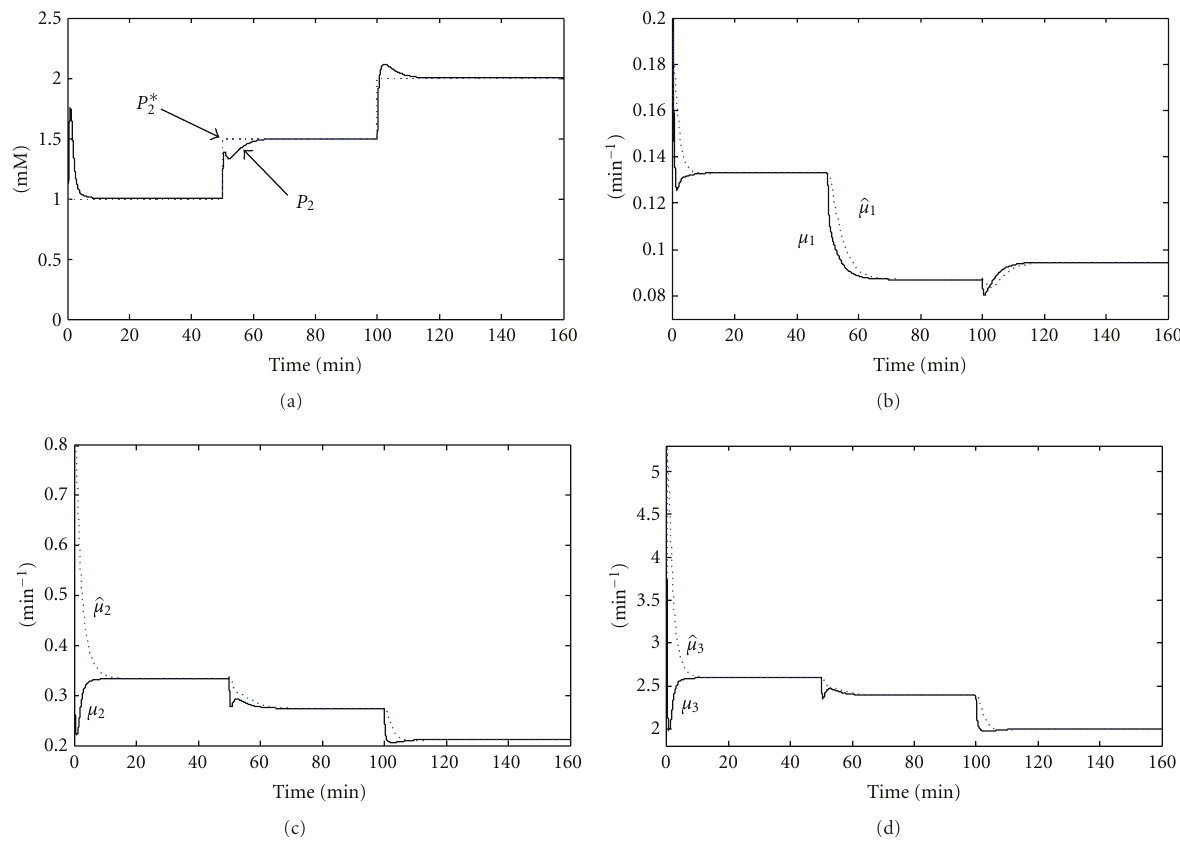
Figure 5: Simulation results—adaptive control law (free-noise measurements). Panel (a) shows the time evolution of the output y = P 2 (ampicillinconcentration) versus the reference profile y ∗ = P ∗ 2 , in the adaptive case. Panels (b), (c), and (d) present the profiles of specific reaction rates μ 1 , μ 2 , and μ 3 together with their estimates (cid:18) μ 1 , (cid:18) μ 2 , and (cid:18) μ 3 , respectively, estimates provided by the nonlinear